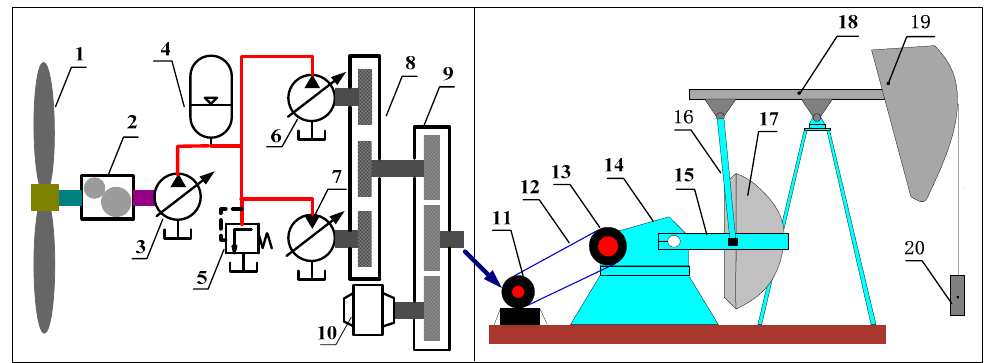
Figure 1. Configuration model of the hydraulic-motor hybrid beam pumping unit. 1. Wind turbine; 2. speed increasing gear; 3. variable pump (1); 4. accumulator; 5. relief; 6. variable pump (2); 7. hydraulic motor; 8. torque coupling gear (1); 9. torque coupling gear (2); 10. electromotor; 11. small pulley; 12. belt; 13. large pulley; 14. reducer; 15. crank; 16. linkage; 17. Balance weight; 18. beam; 19. horsehad; 20. sucker